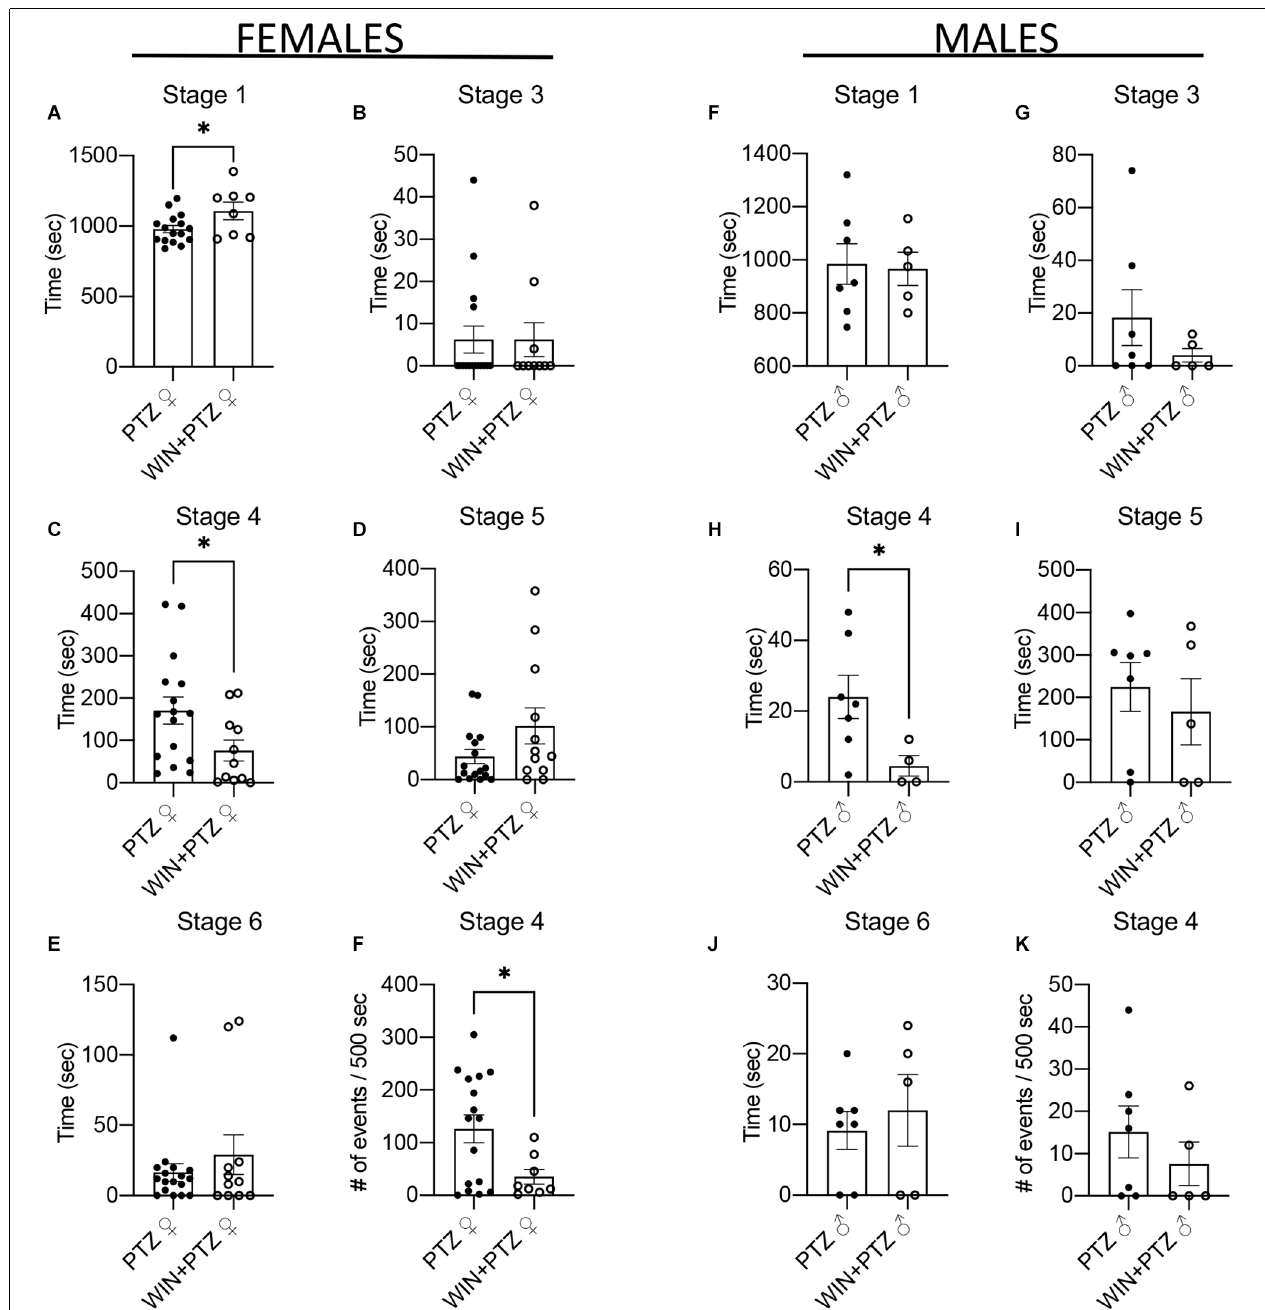
FIGURE 1 | Effect of WIN on PTZ-induced convulsions. (A–E) Seizure duration in females (PTZ: n = 16 for stages 1, 3, 4, 5; and n = 17 for stage 6. WIN + PTZ: n = 8, 10, 11, 12, 11 for stages 1, 3, 4, 5, 6, respectively). (F) Number of times that female rats reach stage 4 in the first 500 s (PTZ n = 9, WIN + PTZ, n = 8). (F–J) Seizure duration in males (PTZ: n = 7 for all stages. WIN + PTZ: n = 5 for stages 1, 3, 5, 6; n = 4 for stage 4). (K) Number of times that male rats reach stage 4 in the first 500 s (PTZ n = 7, WIN + PTZ, n = 5). ∗ p < 0.05, t -test.